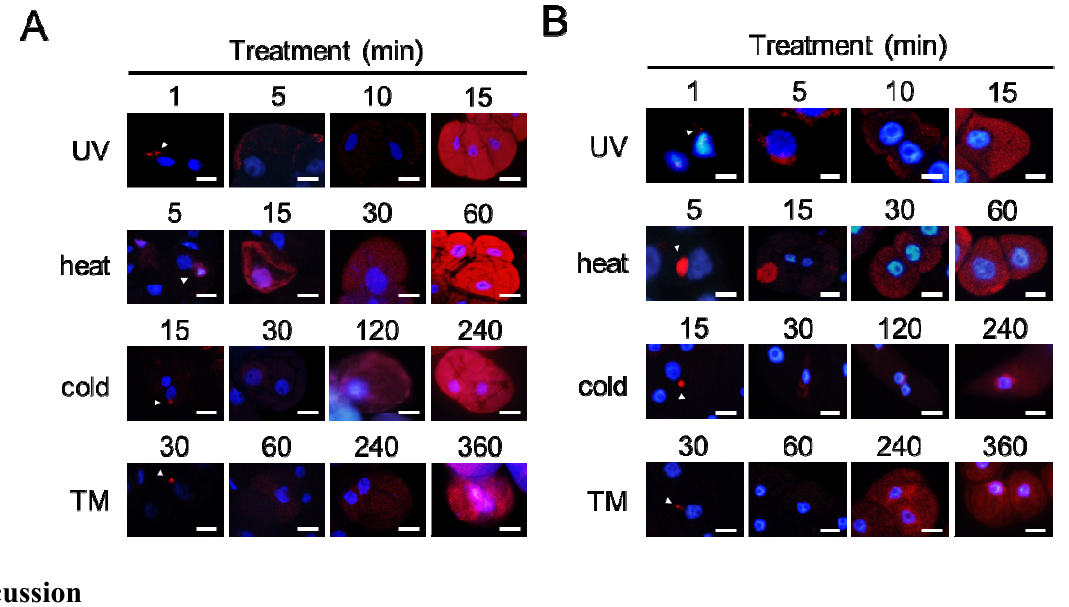
Figure 6. Dynamics of misfolded protein aggregation in plant cells under environmental stress conditions. ( A ) Grape cultured cells; ( B ) Tobacco cultured cells. The cells were fixed at the indicated time after exposure to environmental stresses and then stained. The images are merged images. The red color and the blue color indicate the fluorescence of detected aggregates and stained nuclei, respectively. Arrowheads indicate single or small aggregates. TM, tunicamycin; Scale bars, 20 μ